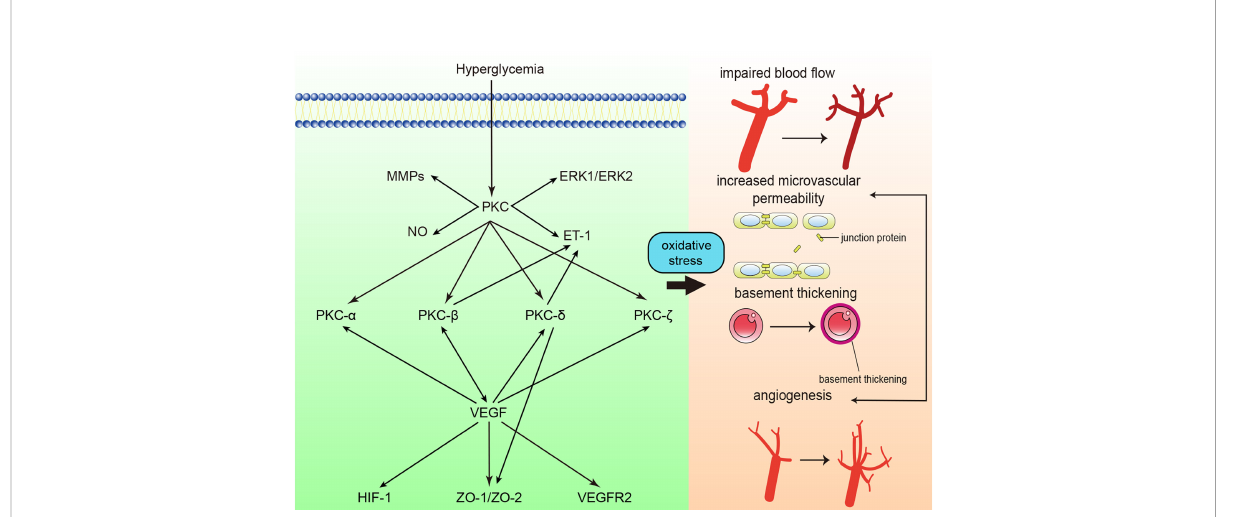
FIGURE 3 Protein kinase C (PKC) in diabetic retinopathy. PKC activation in diabetic retinopathy in fl uences blood fl ow, causes retinal microvascular constriction, induces angiogenesis and increases microvascular permeability. ET-1, endothelin-1; NO, nitric oxide; MMP, matrix metalloproteinase; ERK, extracellular signal-regulated kinase ; VEGF, vascular endothelial growth factor; VEGFR2, vascular endothelial growth factor receptor 2; ZO, zonula occludens; HIF-1, Hypoxia-inducible factor